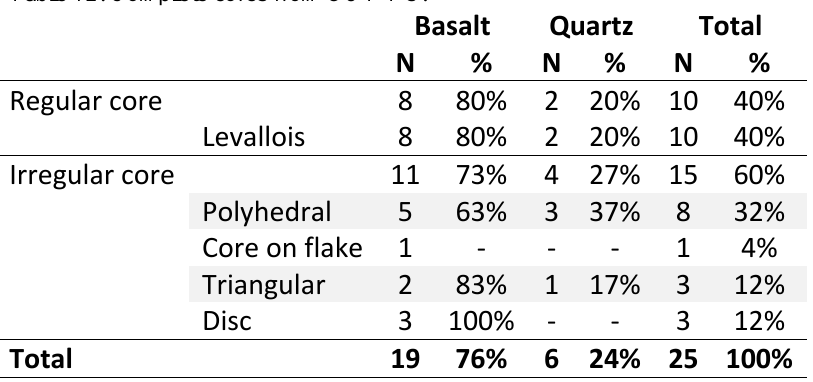
Table 12. Complete cores from GOT